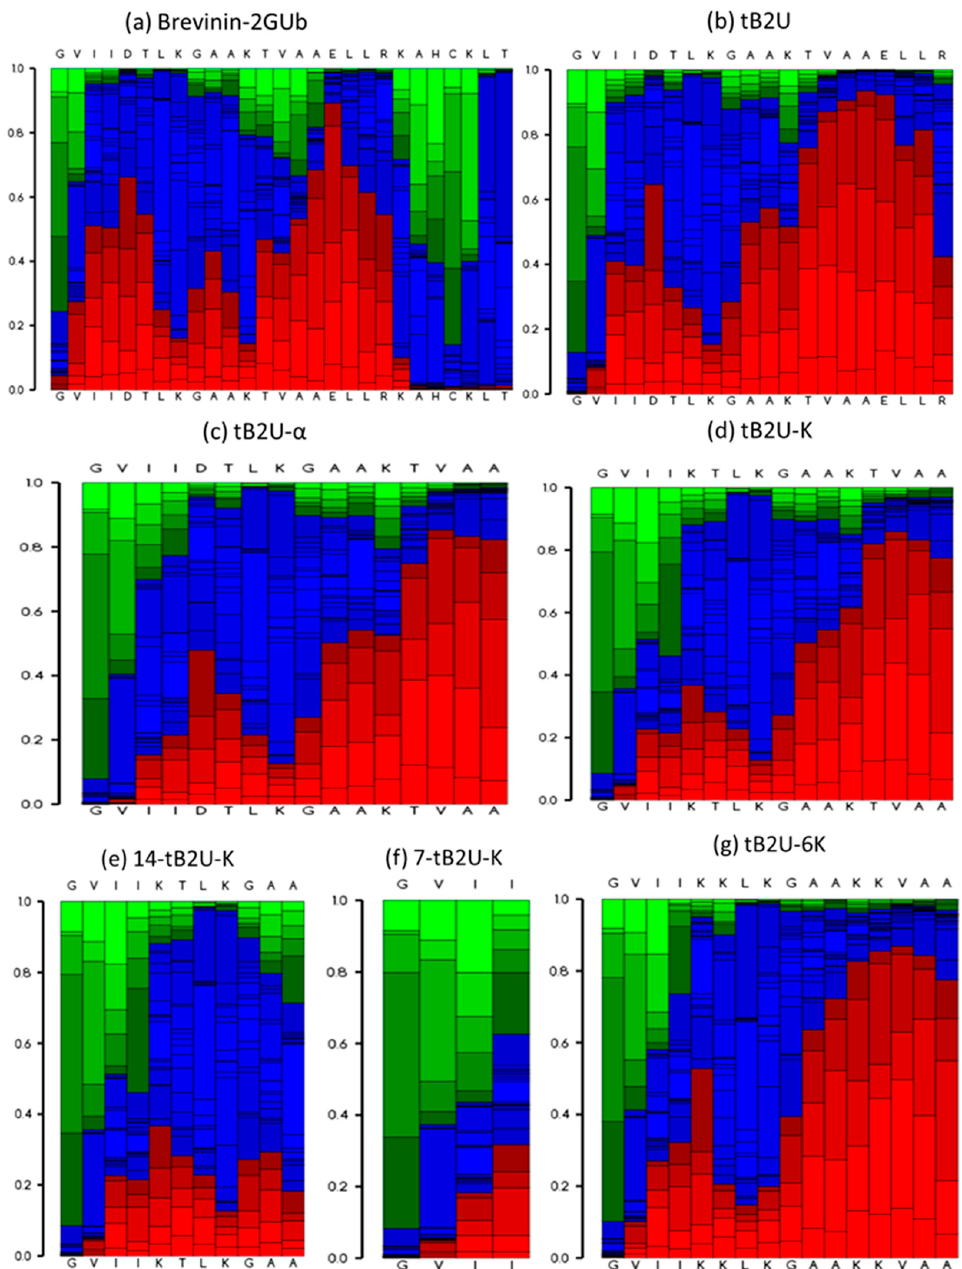
Figure 1. The secondary structure of ( a ) Brevinin-2GUb, ( b ) tB2U, ( c ) tB2U- α , ( d ) tB2U-K, ( e ) 14-tB2U-K, ( f ) 7-tB2U-K, and ( g ) tB2U-6K predicted by the Pep-fold3. The helical, coil, and extended conformation are coloured by red, blue, and green, respectively.